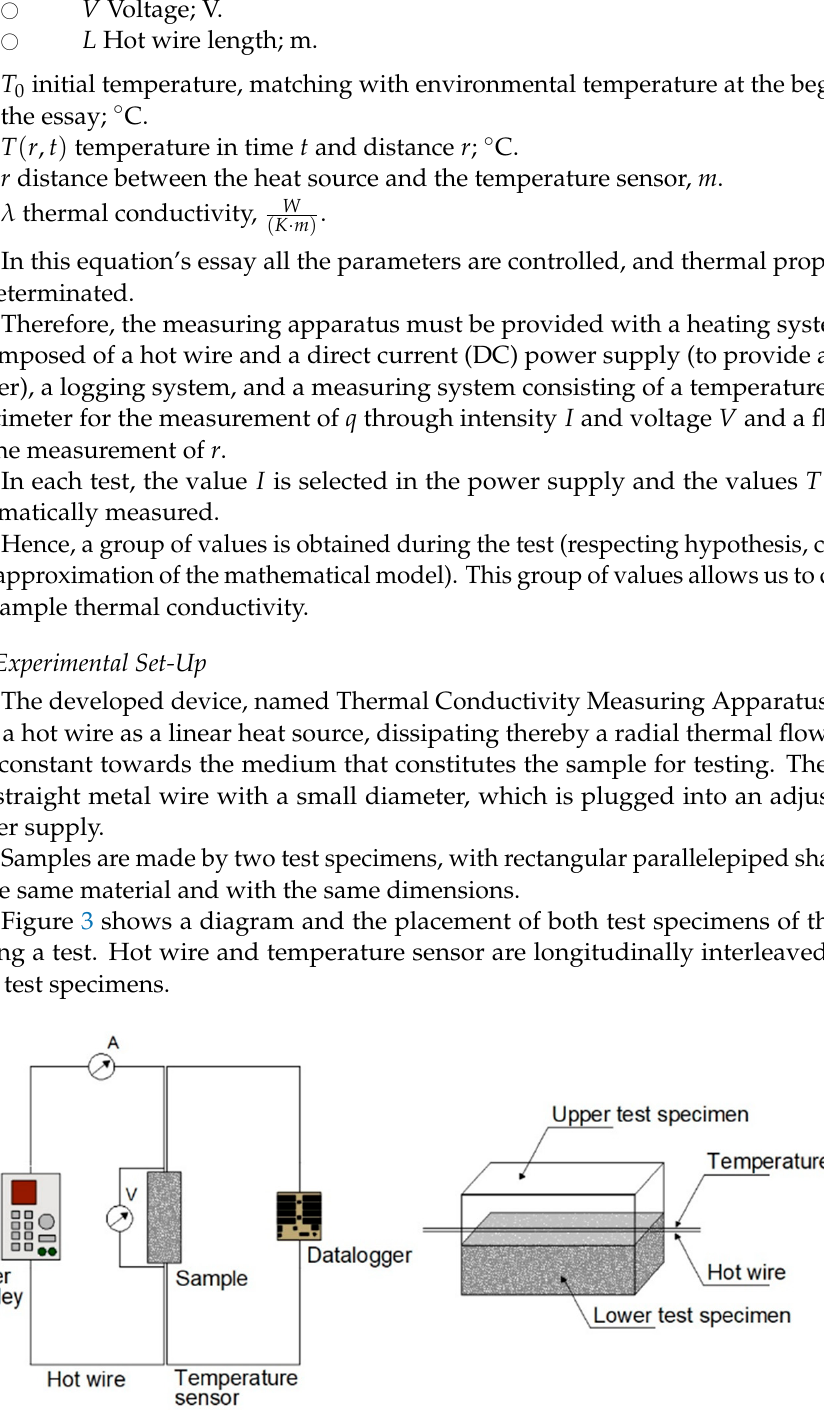
Figure 3. Diagram of the TCMA (top view) and sample disposition.